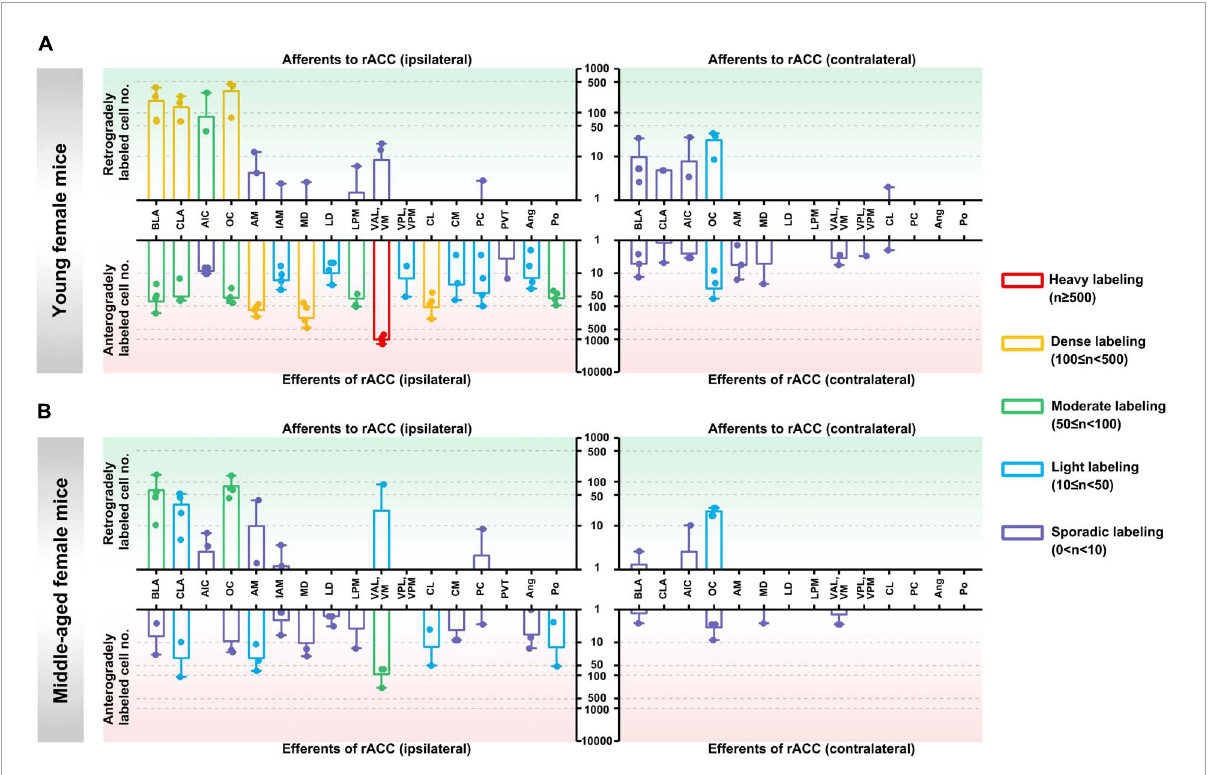
FIGURE3 Afferents and efferents of the rACC in young and middle-aged female mice. (A) The number of retrogradely and anterogradely labeled cells in different brain regions ipsilateral and contralateral to the injection site of the rACC was quantified in young female mice ( n = 3–4 animals, error bars represent s.e.m.). (B) The number of retrogradely and anterogradely labeled cells in different brain regions ipsilateral and contralateral to the injection site of the rACC was quantified in middle-aged female mice ( n = 3–4 animals, error bars represent s.e.m.).